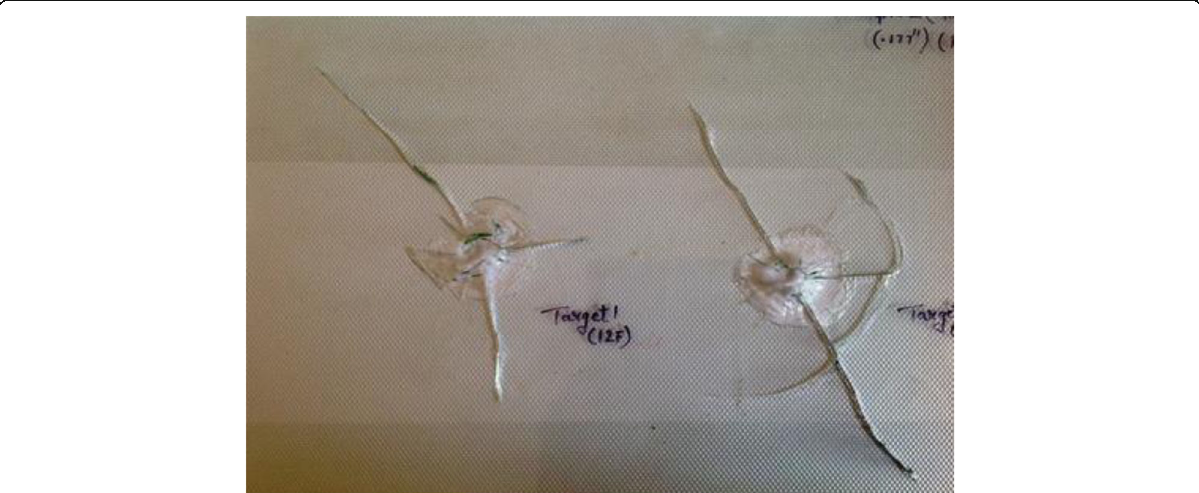
Fig. 3 Multiple fracture on the glass